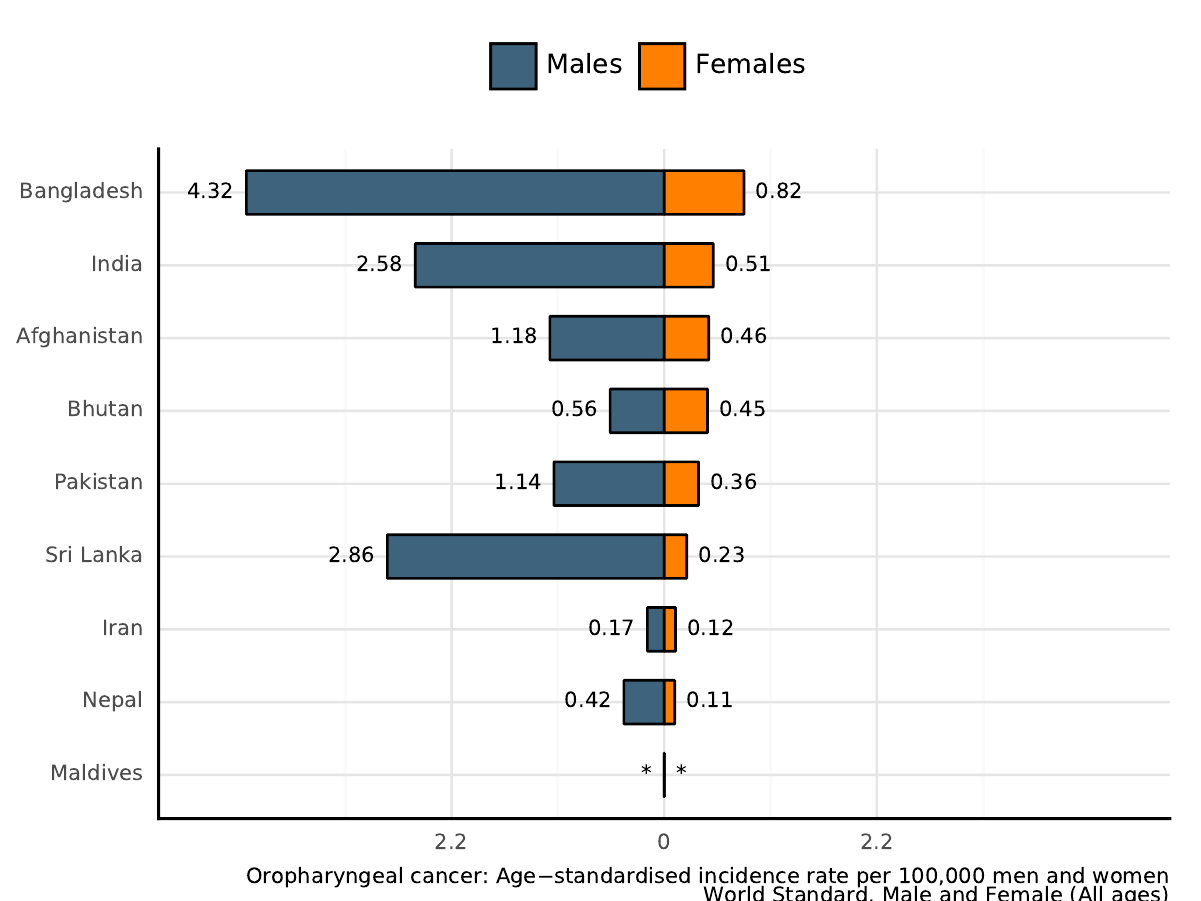
2.2 0 2.2 Oropharyngeal cancer: Age standardised incidence rate per 100,000 men and women World Standard. Male and Female